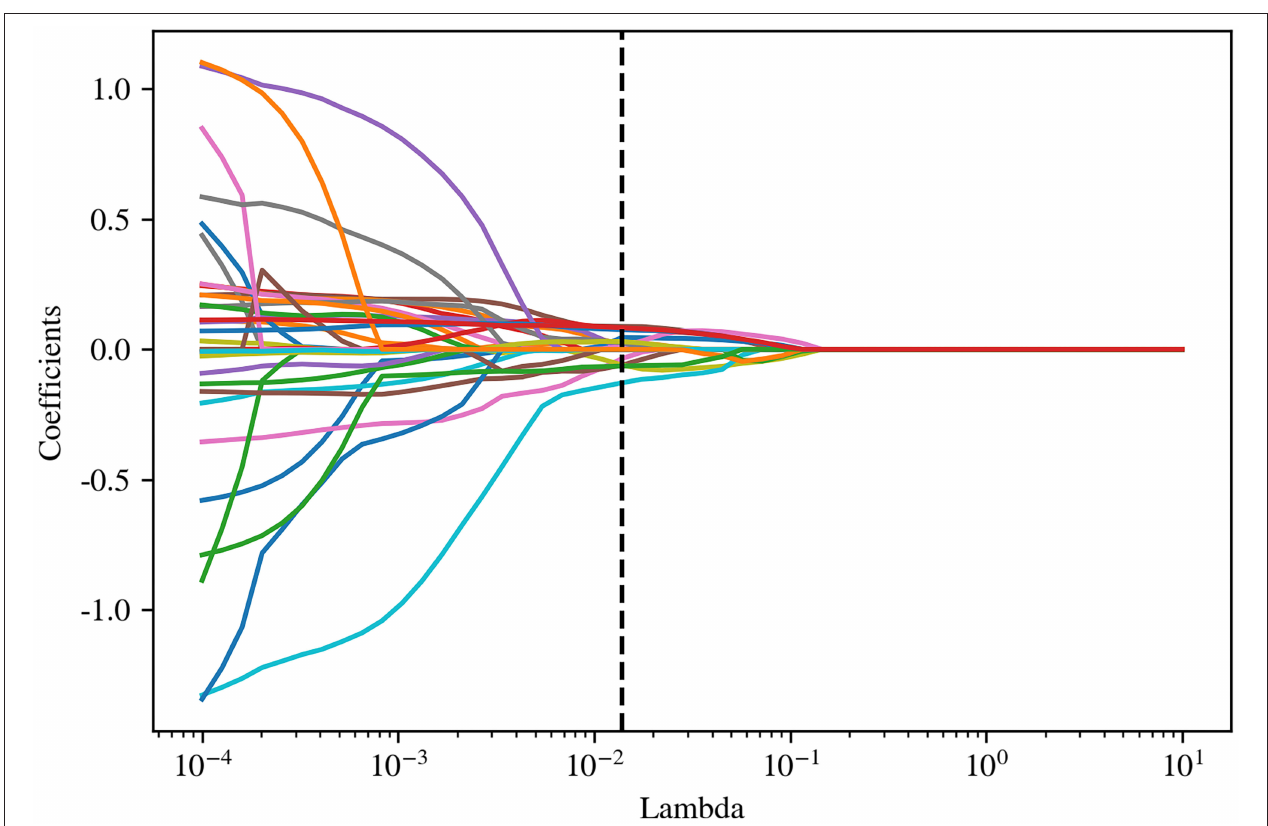
FIGURE 3 | Coefficient profile plot showed the coefficient paths following different lambda